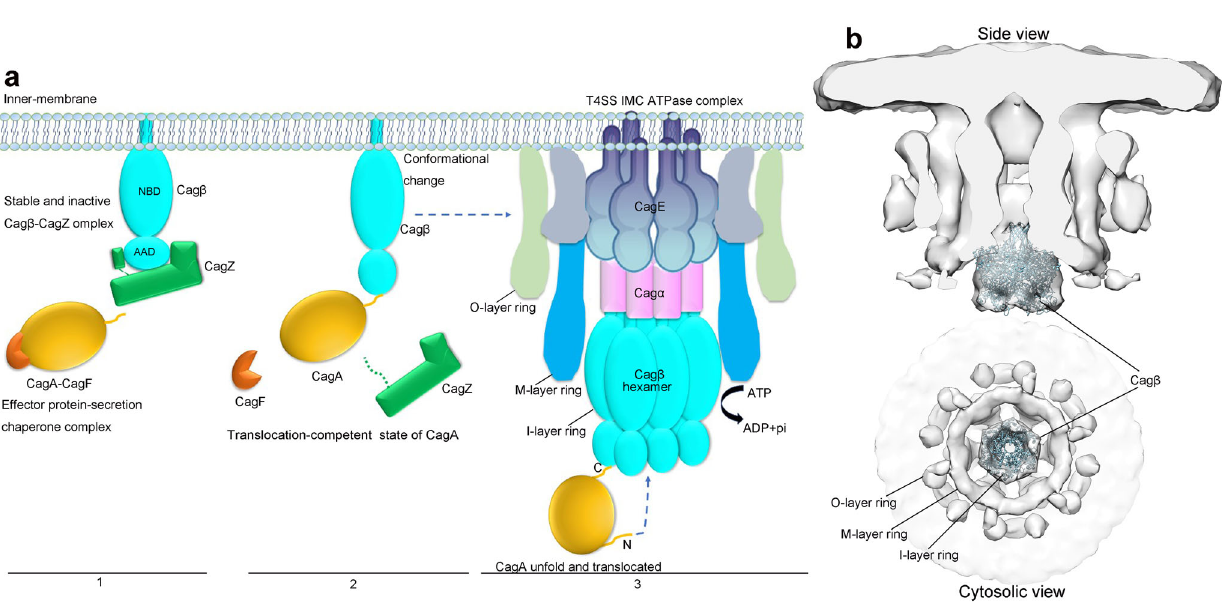
Fig. 7 | A model for CagA recruitment by Cag β ofthe Cag T4SS. a 1, CagA forms an effector-secretion chaperone complex with CagF 36,63 near the inner membrane, whereCag β istrappedintheinactivemonomericstatebyCagZ.2,BindingofCagA triggersthe dissociationof Cag β fromCagZ.3,Cag β formsthehexameranddocks